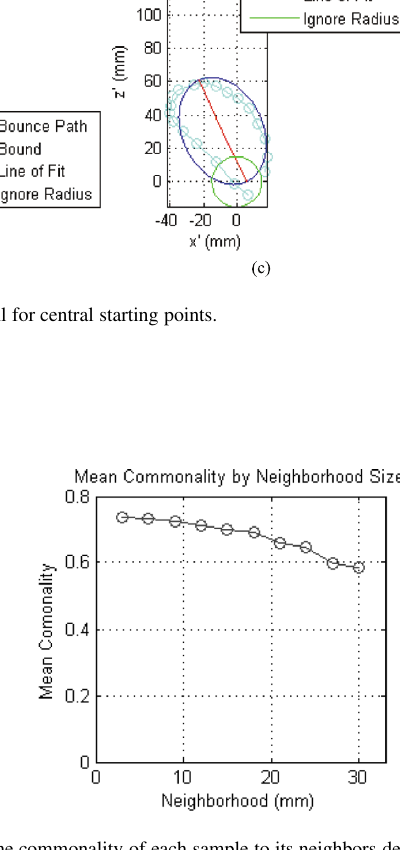
Fig. 19. For bounces with large lateral momentum, the shape of the path does not conform to the ellipse as well.